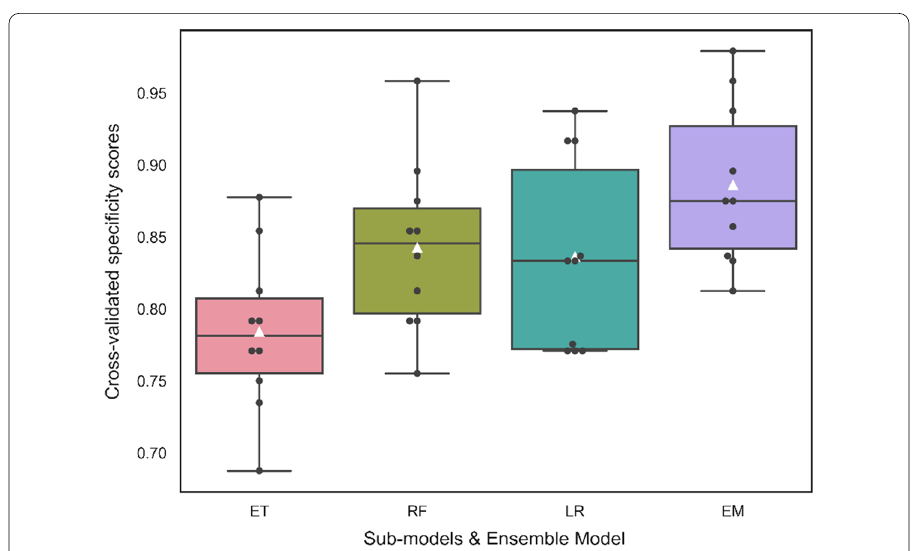
Fig. 5 Comparison of individual sub-models and ensemble